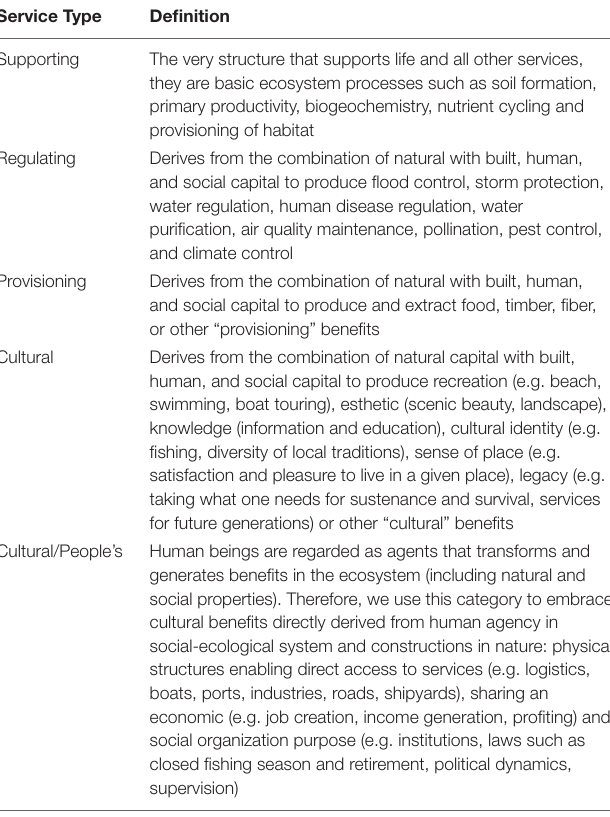
TABLE 1 | Definitions of types of ecosystem services used in this article, adapted from Raymond et al. (2009) and Costanza et al.